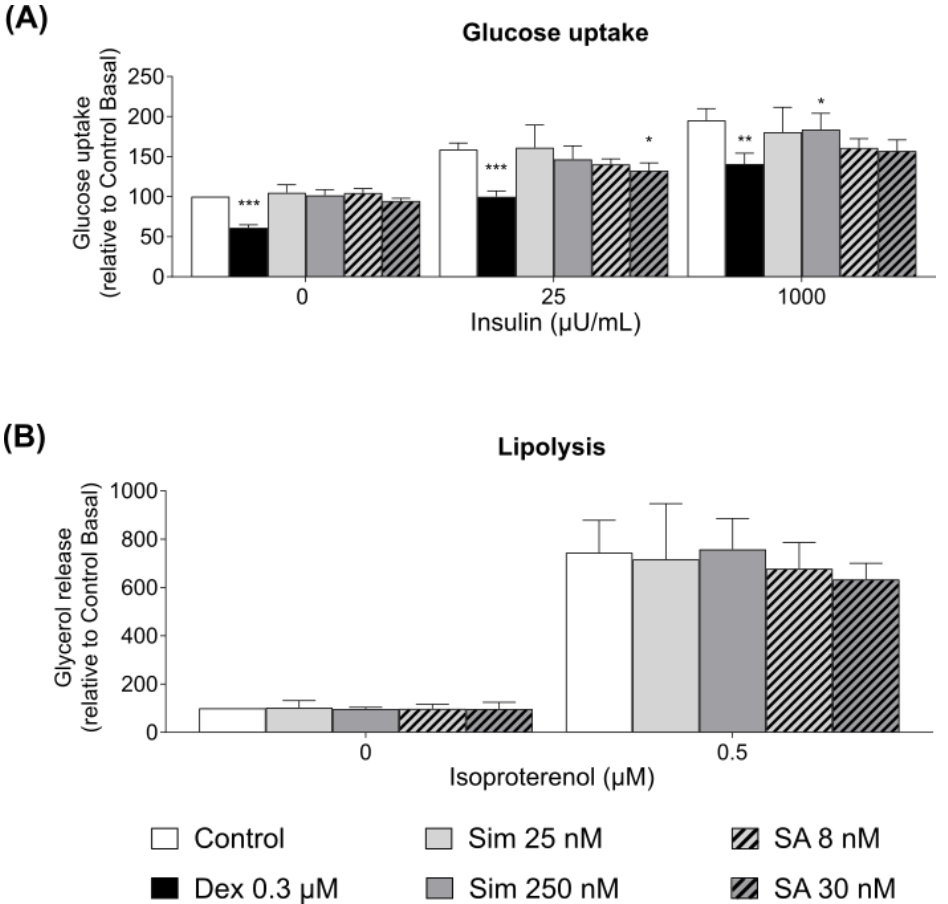
Figure 2. ( A ) Effects of simvastatin and its active metabolite on adipocyte glucose uptake. The graph depicts 14C-glucose uptake by mature human adipocytes isolated from adipose tissue pre-incubated with the given concentrations of simvastatin ( n = 5–7) and simvastatin hydroxy acid ( n = 5) for 24 h at basal (0 µ U/mL), submaximal (25 µ U/mL), and maximal (1000 µ U/mL) insulin concentrations. Dexamethasone (Dex, 0.3 µ M)—positive control ( n = 14). ( B ) Effects of simvastatin and its active metabolite on adipocyte lipolysis. The graph shows basal and isoproterenol-stimulated lipolysis measured by glycerol release by mature human adipocytes isolated from adipose tissue pre-incubated with the given concentrations of simvastatin ( n = 4) and simvastatin hydroxy acid ( n = 3) for 24 h. Graph shows mean ± S.E.M. * p < 0.05, ** p < 0.01, and *** p < 0.001, relative to